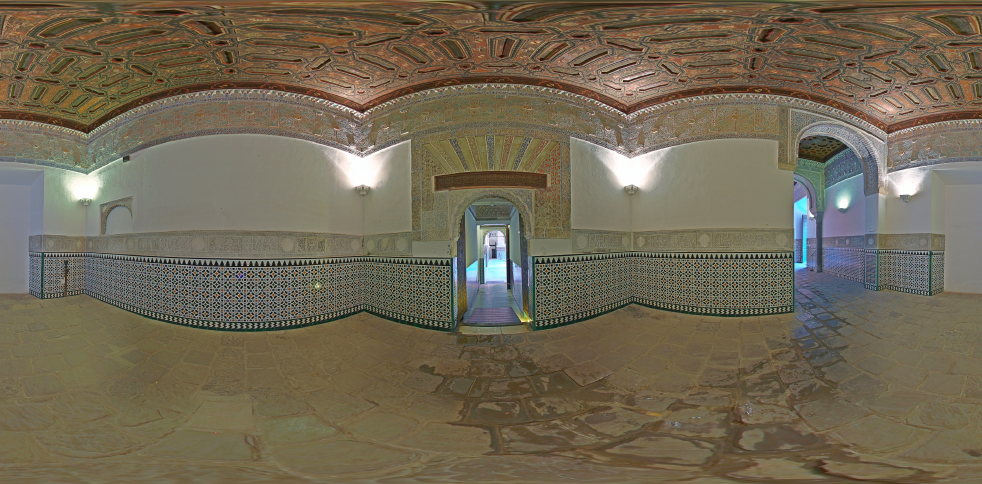
Figure 2. A spherical image acquired in the Alcázar of Seville (Spain).